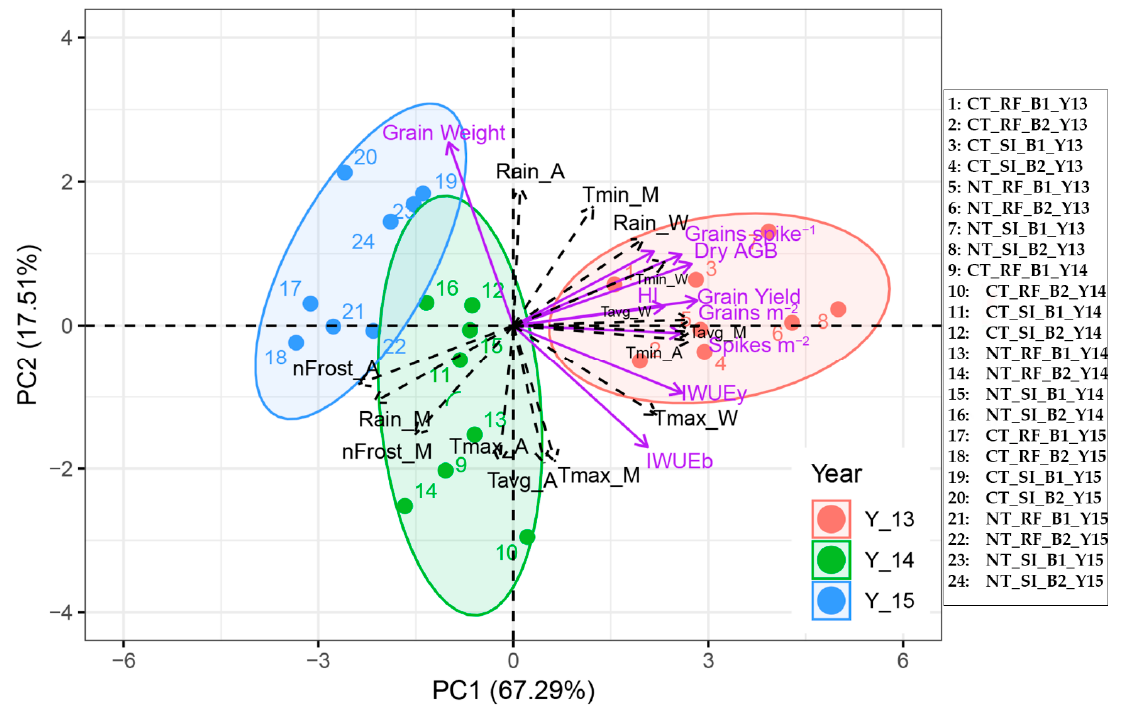
Figure 3. Principal component loading plots and scores of principal component analysis for dry biomass (AGB), yield, yield components and irrigation water use efficiencies (IWUE b , IWUE y ) in barley as function of year, agronomic management, water regime and cultivar.